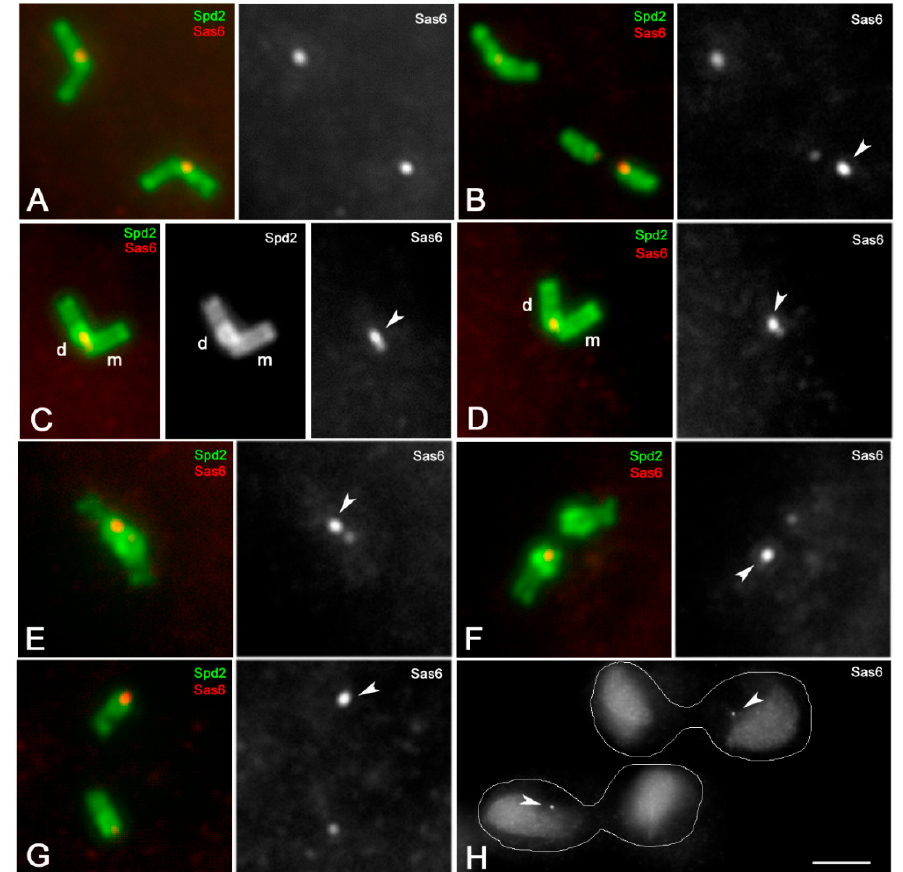
Figure 4. Localization of Sas6 during meiotic progression. Centrioles expressing Sas6-GFP (red) are counterstained with an antibody against Spd2 (green). The brighter Sas6-GFP spots (arrowheads) are associated with the daughter centrioles. ( A – D ) Mature primary spermatocytes. The centrioles in panel ( C ) are a representative pair in which the daughter (d) is orthogonal to the basal region of the mother (m). ( E ) Metaphase I. ( F ) Anaphase I. ( G ) Telophase I. ( H ) Only one sister cell of the secondary telophase spermatocytes inherits the brighter Sas6-GFP dot (arrowheads). m and d, are mother and daughter centrioles, respectively. Scale bar: ( A – G ); 2 µ m; ( H ), 10 µ